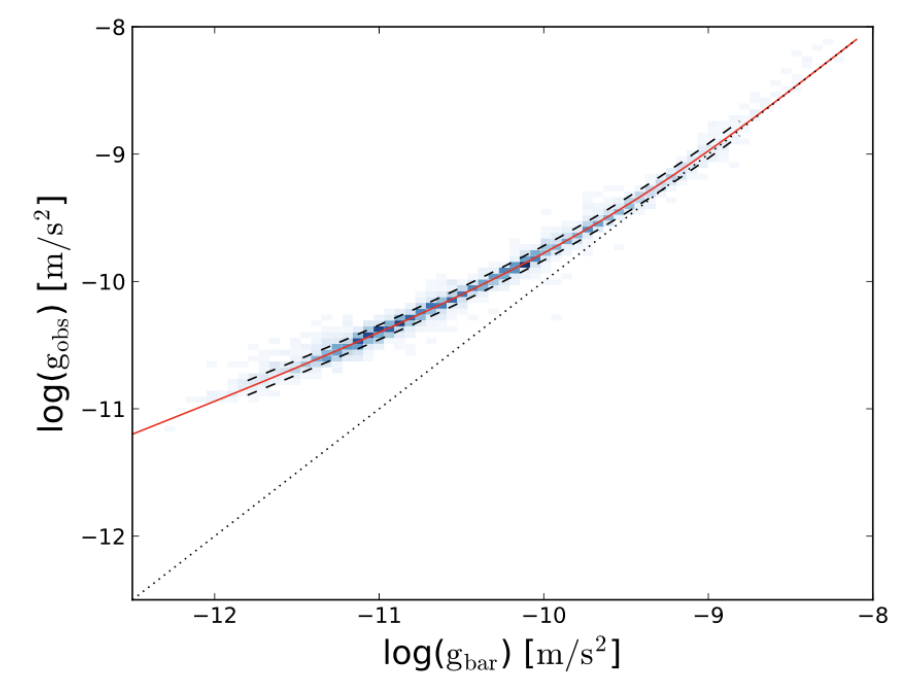
Figure 4. Radial Acceleration Relation (RAR), the observed centripetal acceleration versus the Newtonian acceleration due to baryonic matter alone. The blue color-scale rectangles show 2694 individual measured points from the rotation curves of 153 SPARC galaxies. The red solid line is the fitted RAR given by Equation (4), whereas the black dotted line represents the one-to-one relation, for comparison. The figure is reproduced from